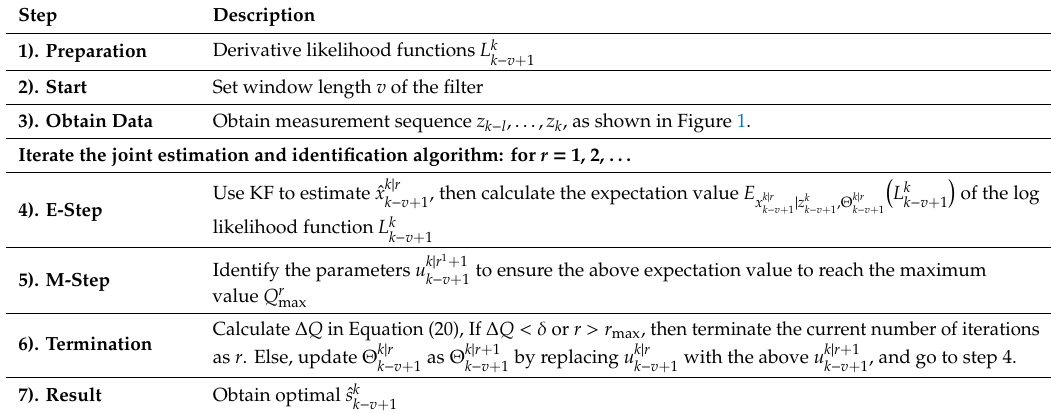
Table 1. Recursive computation process of the proposed